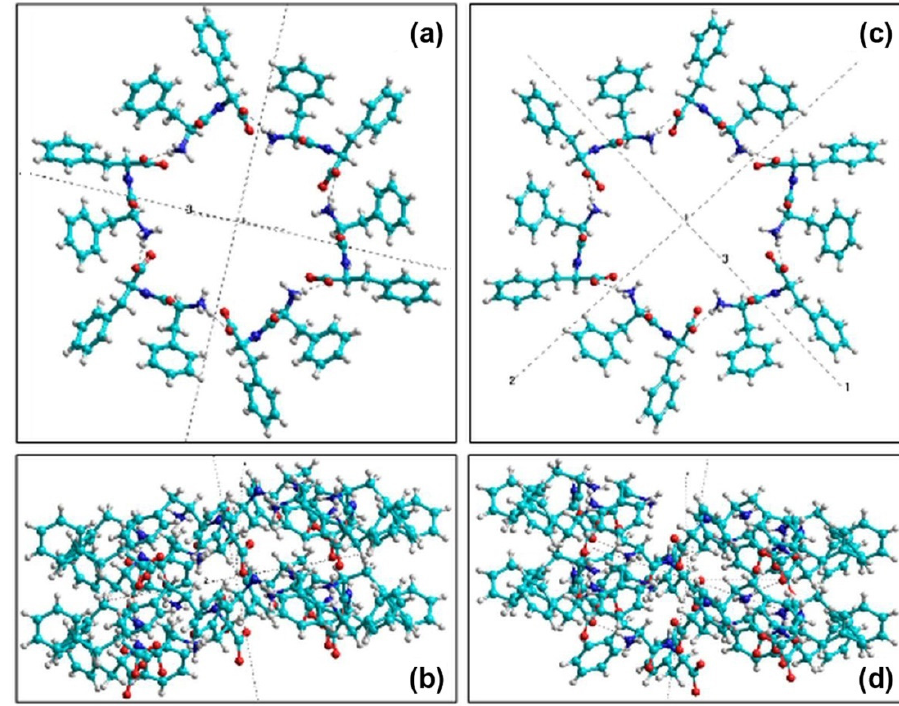
Figure 2. Two coils of FF PNT in HyperChem workspace based on experimental crystallographic data [31,38]: ( a ) L-FF in the Z-plane, ( b ) L-FF in the Y-plane, ( c ) D-FF in the Z-plane, and ( d ) D-FF in the Y-plane.